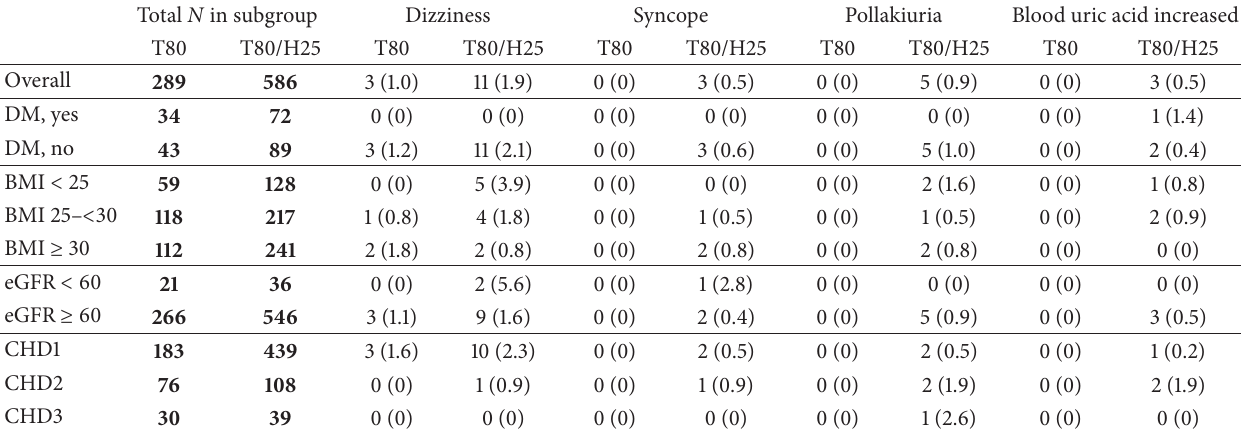
Table 5: Frequency of the most commonly observed treatment-related AEs occurring in patients receiving SPC T80/H25 treatment: by treatment group and patient subpopulation; N (%): based on treated